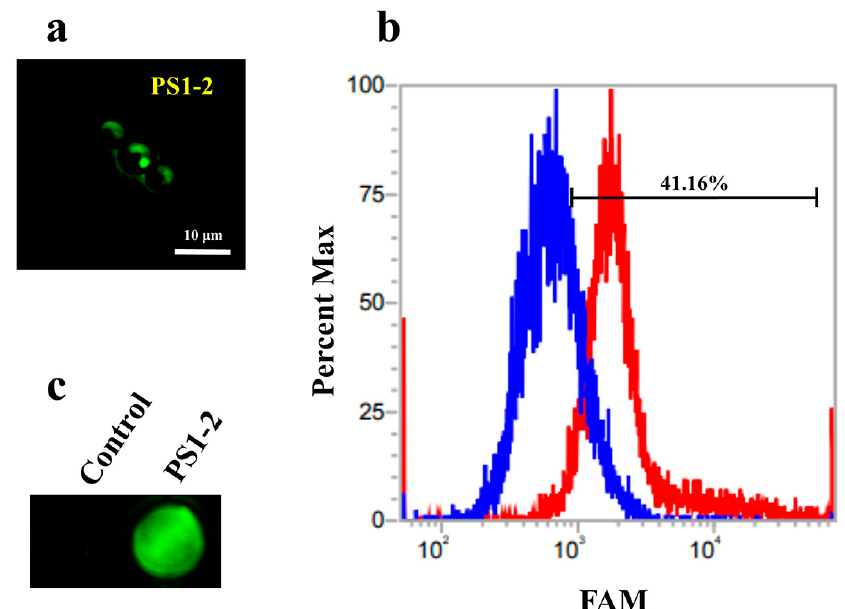
Figure 2. Binding affinity of 5-carboxyfluorescein (FAM)-labeled PS1-2 peptide. After incubation of FAM-labeled PS1-2 peptide for 1 min, C. albicans cells were three times washed with PBS, observed under fluorescence microscope ( a ), analyzed using flow cytometry ( b ), and visualized under fluorescence signal imaging system ( c ), blue line: C. albicans , red line: C. albicans with FAM-labeled PS1-2).